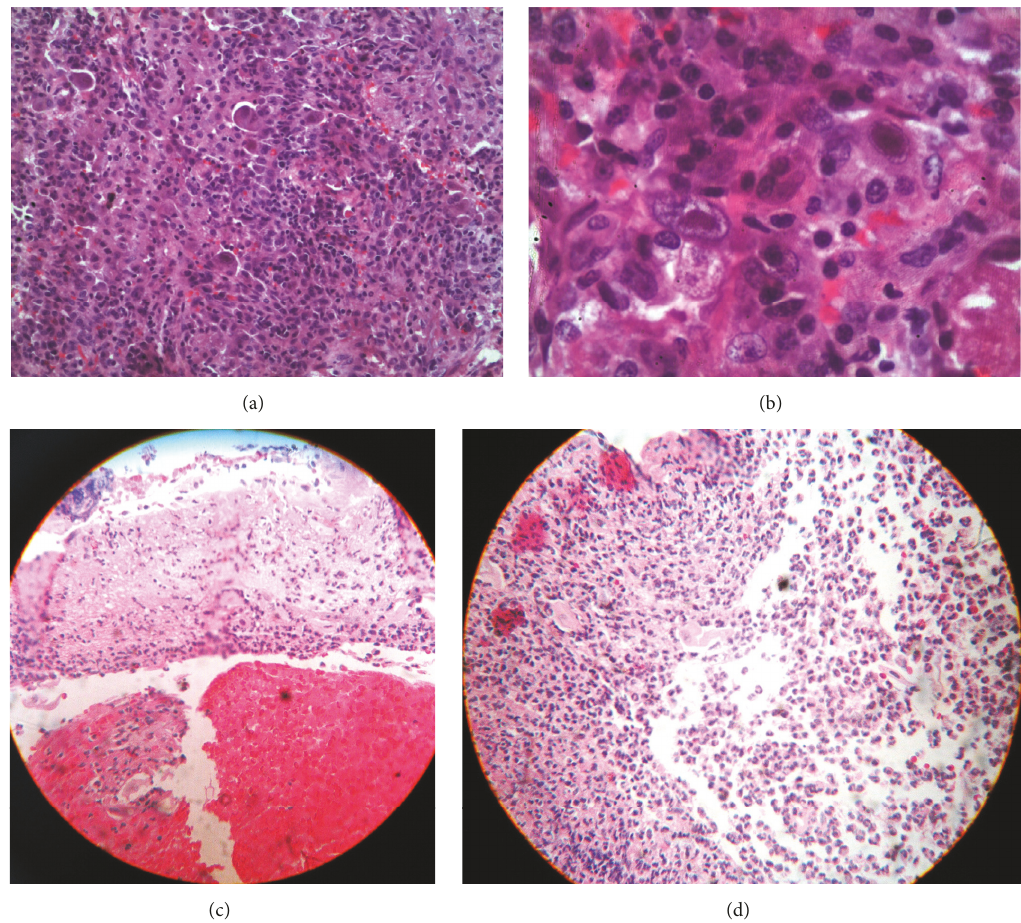
Figure 2: Panel (a): lung biopsy with pulmonary tissue showing young fibroblast proliferation at the interstitial level with lymphocytes, histiocytes, and red blood cells. Panel (b): abundant cytomegalovirus inclusions and alveolar spaces with type II pneumocytes and red blood cells. Ziehl-Neelsen, Grocott, and periodic acid-Schiff stain (PAS) were negative. Panel (c): esophagus biopsy with loss of mucosal continuity and the presence of hemorrhage. Panel (d): important infiltration of polymorphonuclear cells and epithelioid cells with a few fragments of squamous epithelia. Acid fast bacilli stain and fungal stains were